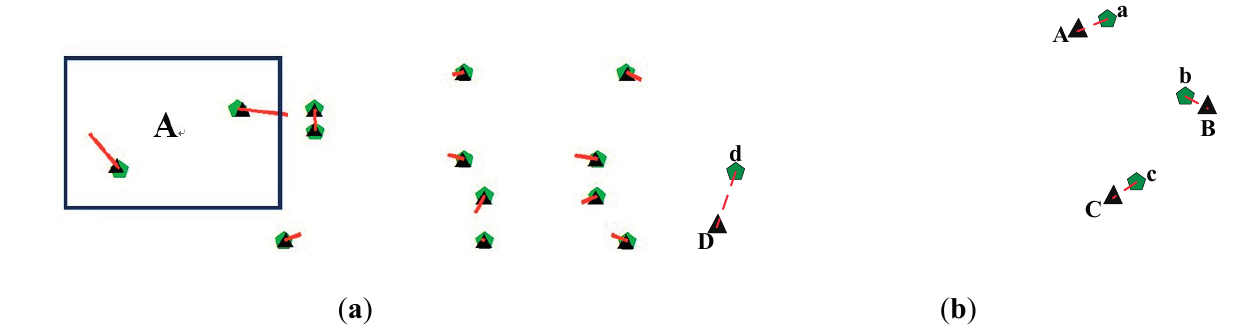
Figure 3. Basis for the shiftable leading point method. ( a ) Example of extracted airborne corners (green pentagons refer to true airborne corners; black triangles refer to airborne corners; red straight lines refer to error vectors, which are amplified 10 times); ( b ) example of unevenly distributed corners (green pentagons refer to true airborne corners; black triangles refer to airborne